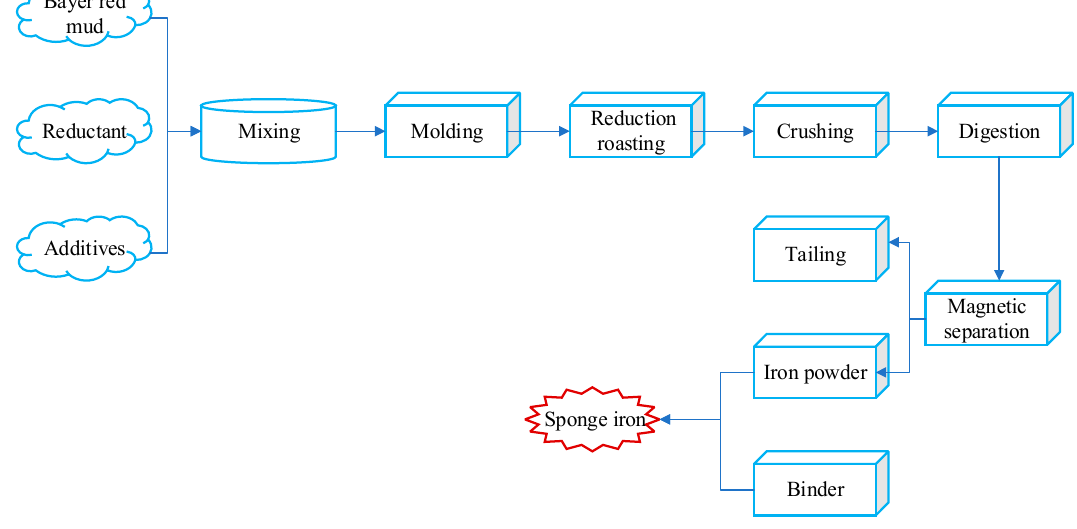
Figure 13. Production process of sponge iron from RM [117].